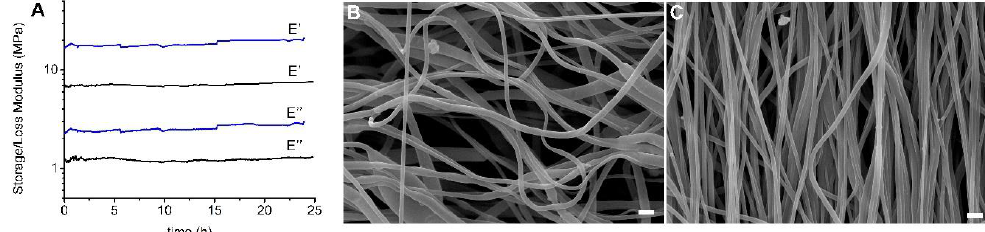
Figure 4. ( A ) Dynamic-mechanical curves of RND (black) and ALN (blue) scaffolds. SEM images after dynamic-mechanical analysis of RND ( B ) and ALN ( C ) scaffolds. Scale bar = 2 µm. Wettability and hydrolytic degradation of P(BCE-co-TECE) electrospun scaffolds, which are